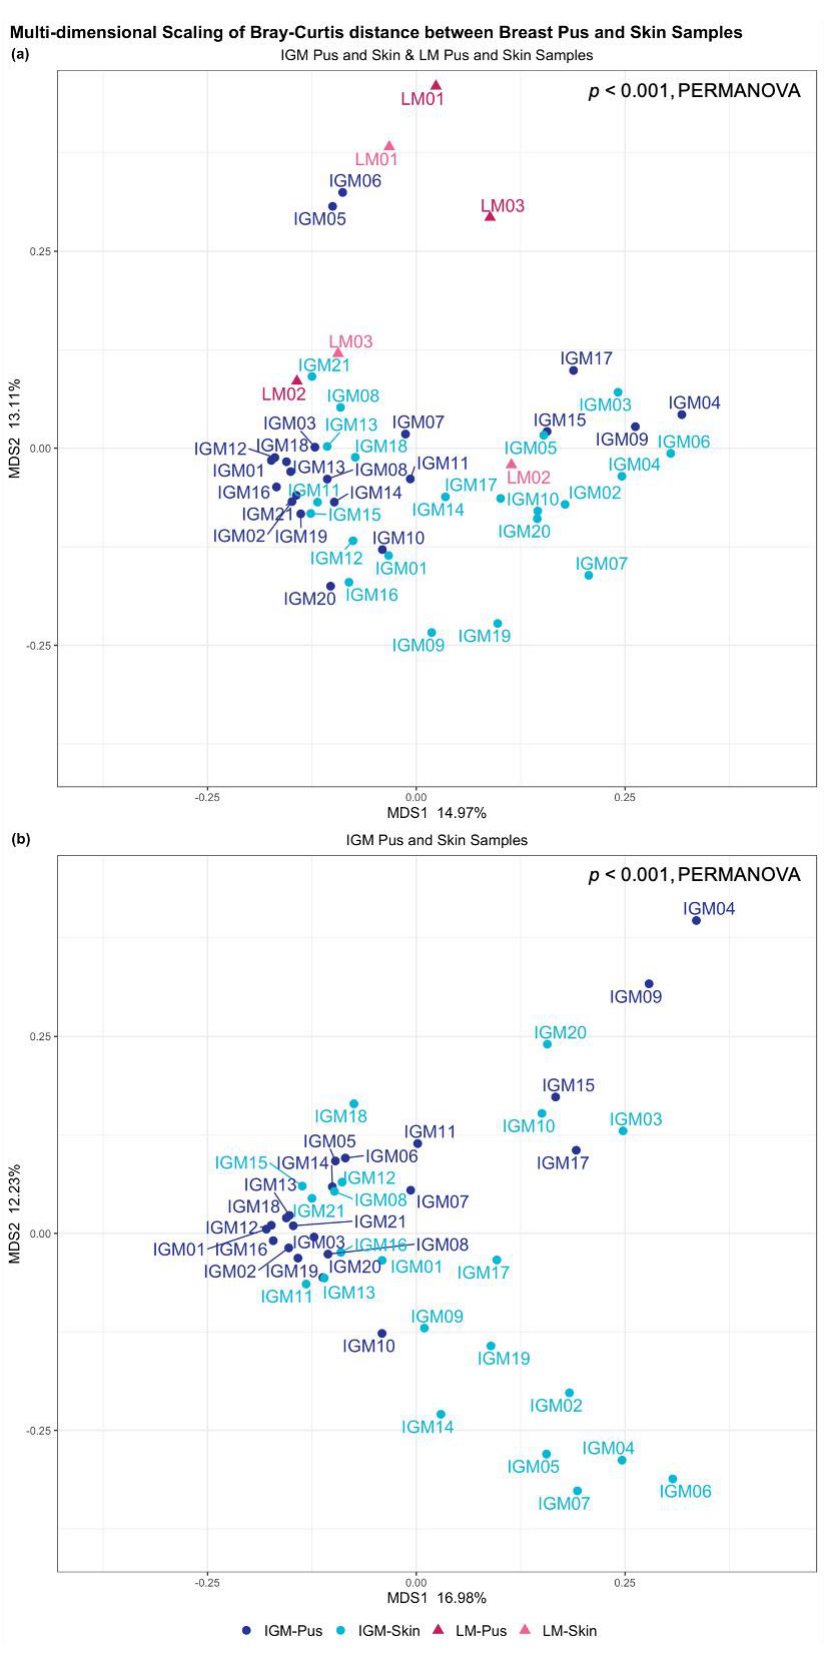
Figure 2. Multi-dimensional scaling (MDS) (principal coordinate analysis (PCoA)) of the Bray − Curtis distance between breast pus and skin samples from ( a ) patients with idiopathic granulomatous